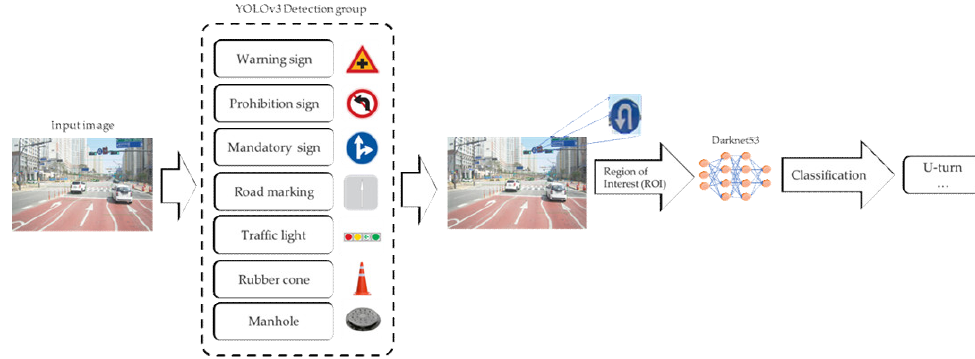
Figure 8. Designed structure to be classified.